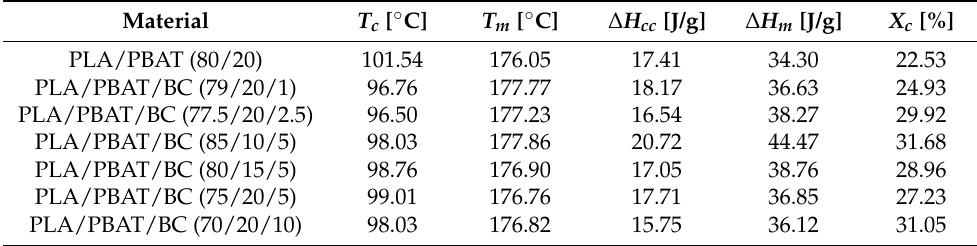
Table 2. Thermal properties of the PLA/PBAT/BC composites.